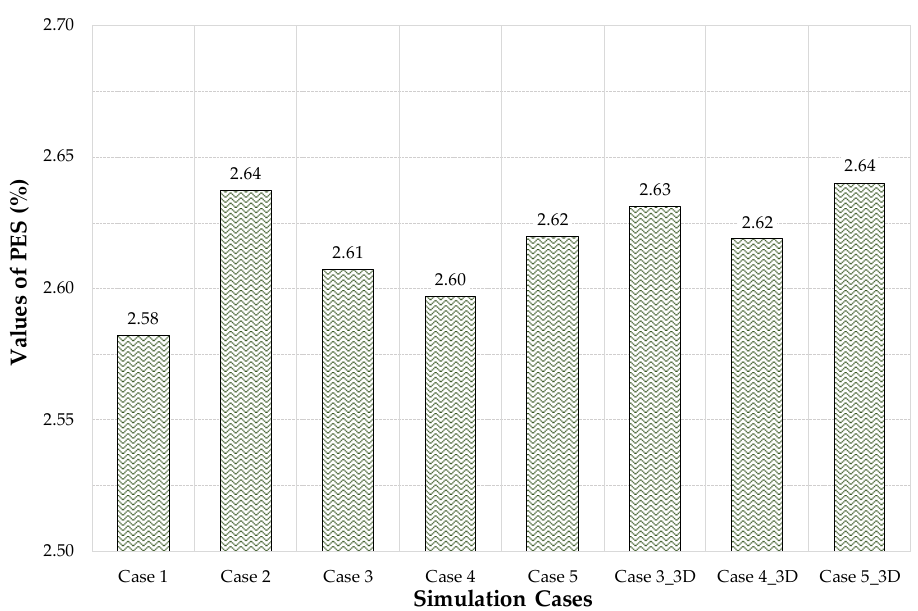
Figure 14. Values of PES upon varying the case studies.